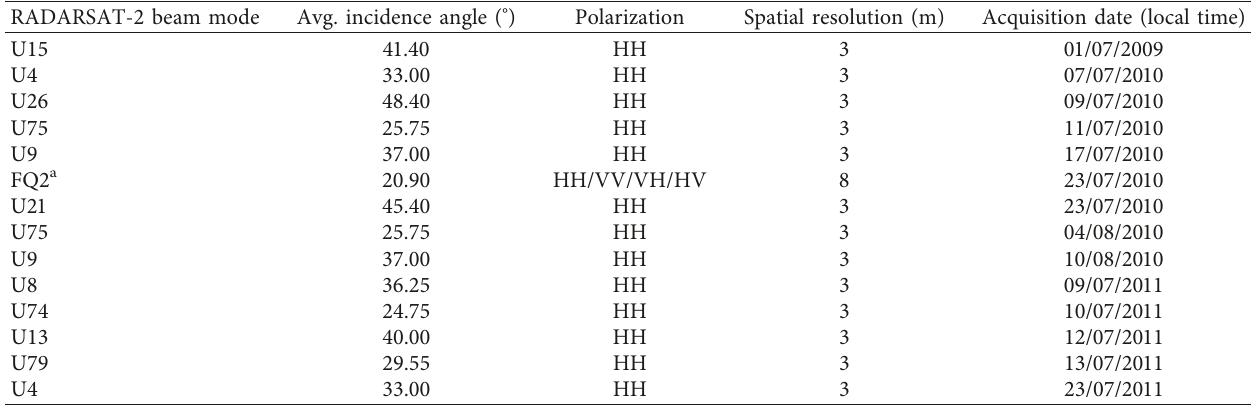
Figure 5: Local variance and rate of change values produced by the ESP tool for the Cape Bounty Arctic Watershed Observatory. Table 1: RADARSAT-2 data used in the